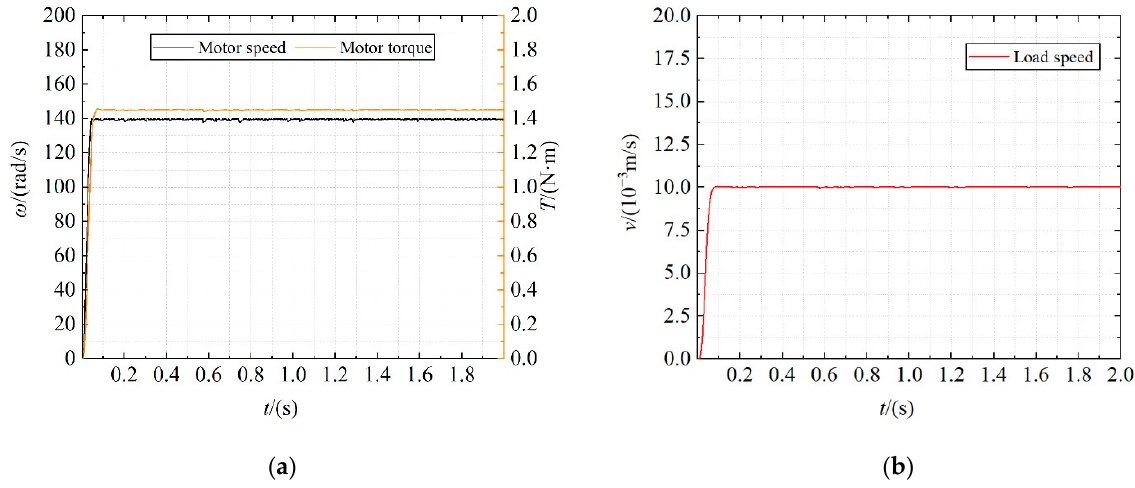
Figure 17. ( a ) The motor speed and torque of HTD; ( b ) The load speed of HTD.